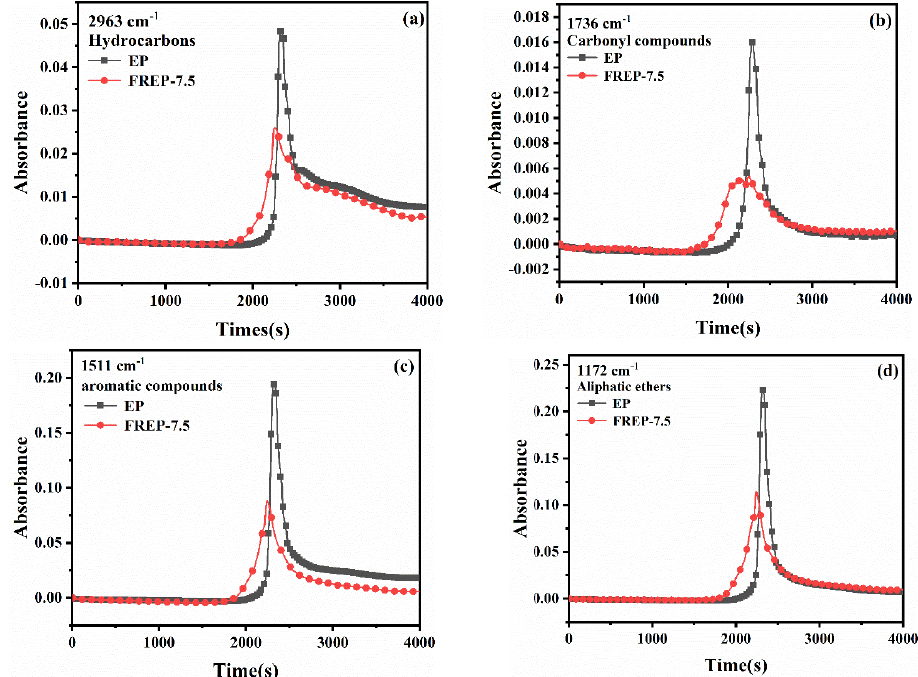
Figure 11. Absorption intensity versus time for several typical volatiles of EP and FREP-7.5, hy- drocarbons ( a ), carbonyl compounds ( b ), aromatic compounds ( c ), aliphatic ethers ( d ).